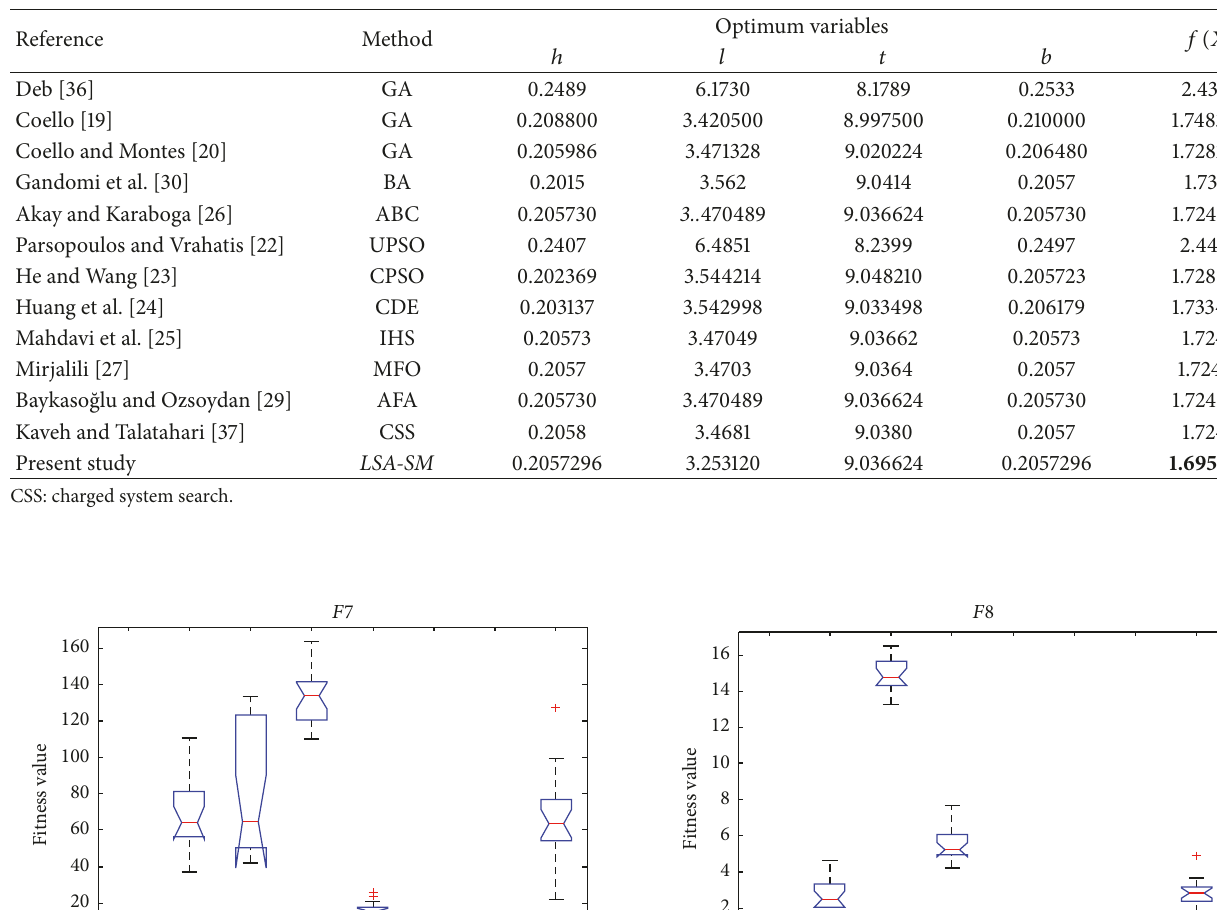
Table 11: Best results of the welded beam design by different methods.